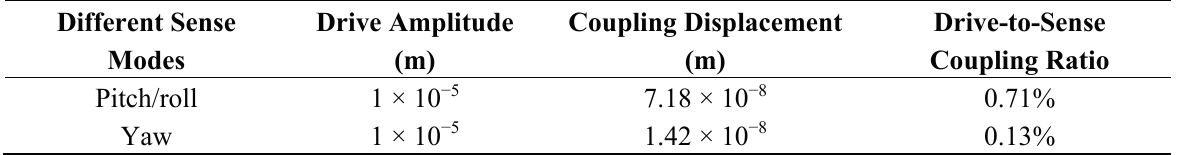
Table 5. Simulation results of cross-axis